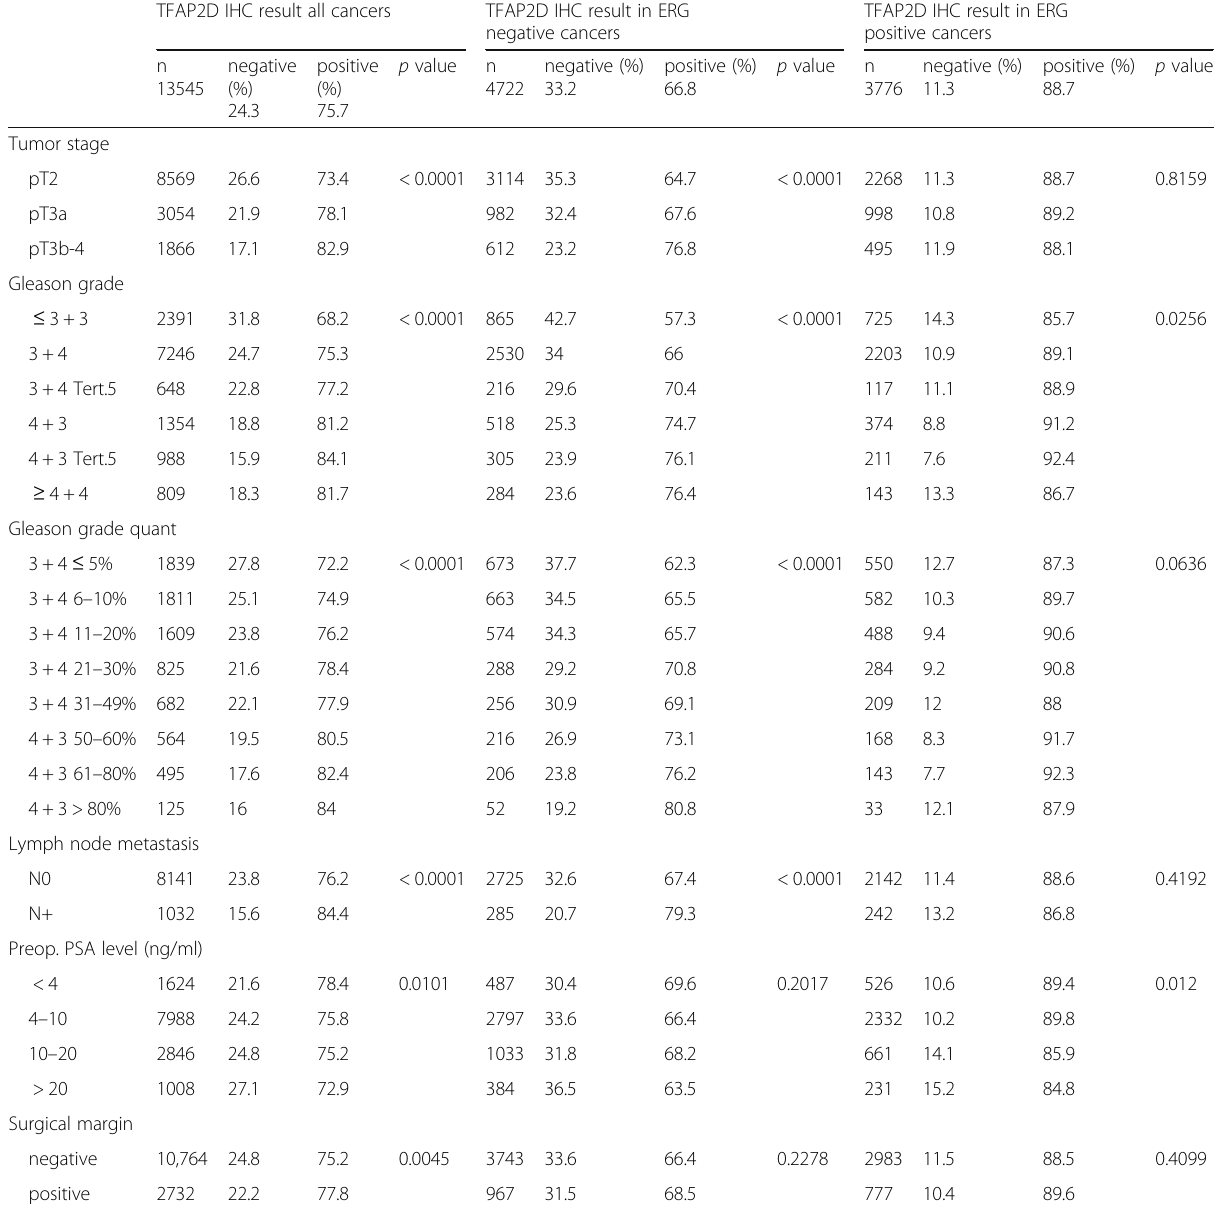
Table 2 TFAP2D immunostaining results and prostate cancer phenotype in all cancers, ERG negative cancers, and ERG positive cancers TFAP2D IHC result all cancers TFAP2D IHC result in ERG negative cancers